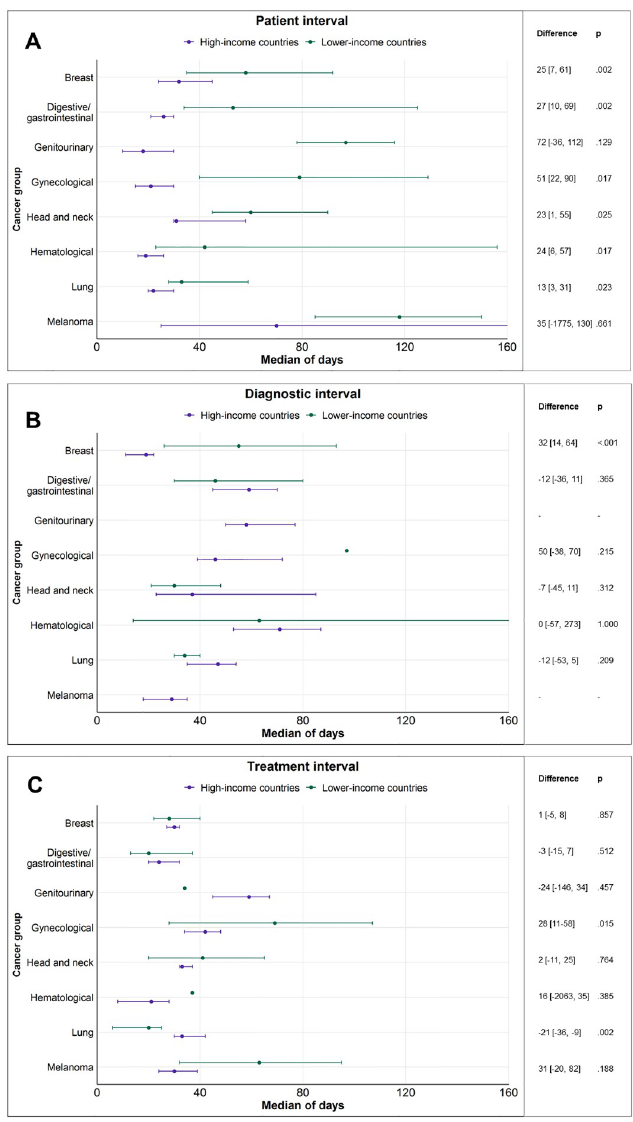
Fig 3. Pooled median duration and 95% CIs for the patient (A), diagnostic (B), and treatment (C) intervals for the main cancer groups and as a function of GNI (classified into high- and lower-income) of the countries represented. Note: The lack of CI means that the median represents 1 available study only. When the whiskers for the upper limit of the CI are not seen, the limit is higher than the axis maximum ( > 160). Difference = estimated difference (and 95% CIs in square brackets) between lower- and high-income countries based on Wilcoxon rank sum test. CI, confidence interval; GNI, gross national income. gynecological cancers (R 2 = 31% based on GNI and 29% based on HDI); and 60 days [45 to 90] versus 31 days [30 to 58] for head and neck cancers (R 2 = 8% based on GNI and 17% based on HDI). Differences for the rest of the main cancer groups were less pronounced but still sig- nificant: 42 days [23 to 156] versus 19 days [16 to 26] for hematological; 50 days [34 to 90] ver- sus 29 days [19 to 45] for breast; and 33 days [28 to 59] versus 22 days [20 to 30] for lung cancers. Results were similar and differences generally more pronounced using the continuous HDI compared to the binary GNI classification (see S6 Table).